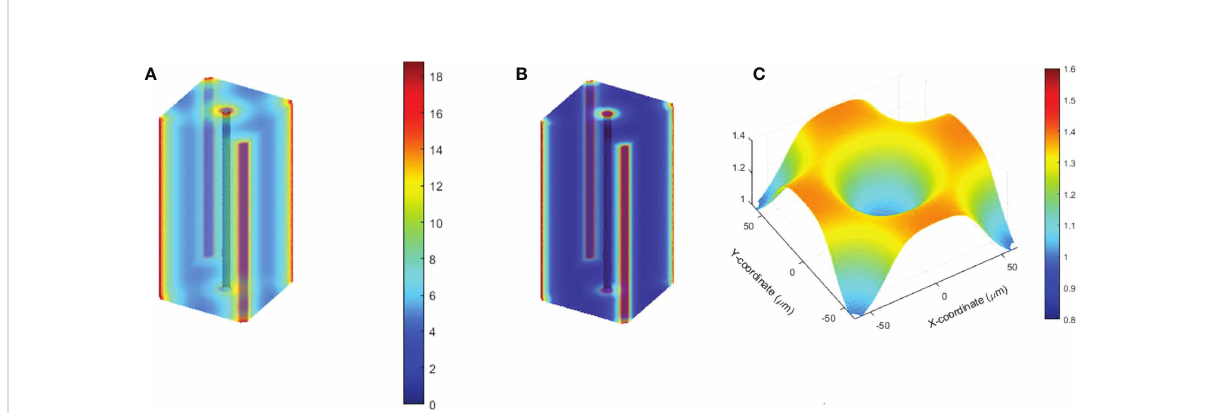
FIGURE 9 Semi-transparent 3D plots of the oxygen distribution under 15 Gy at (A) 0.5 Gy/s and (B) 125 Gy/s. The distance from the center vessel to the edge vessels is 88.4 m m. (C) The resulting FEDMF in the cross-section plane at half of the cuboid